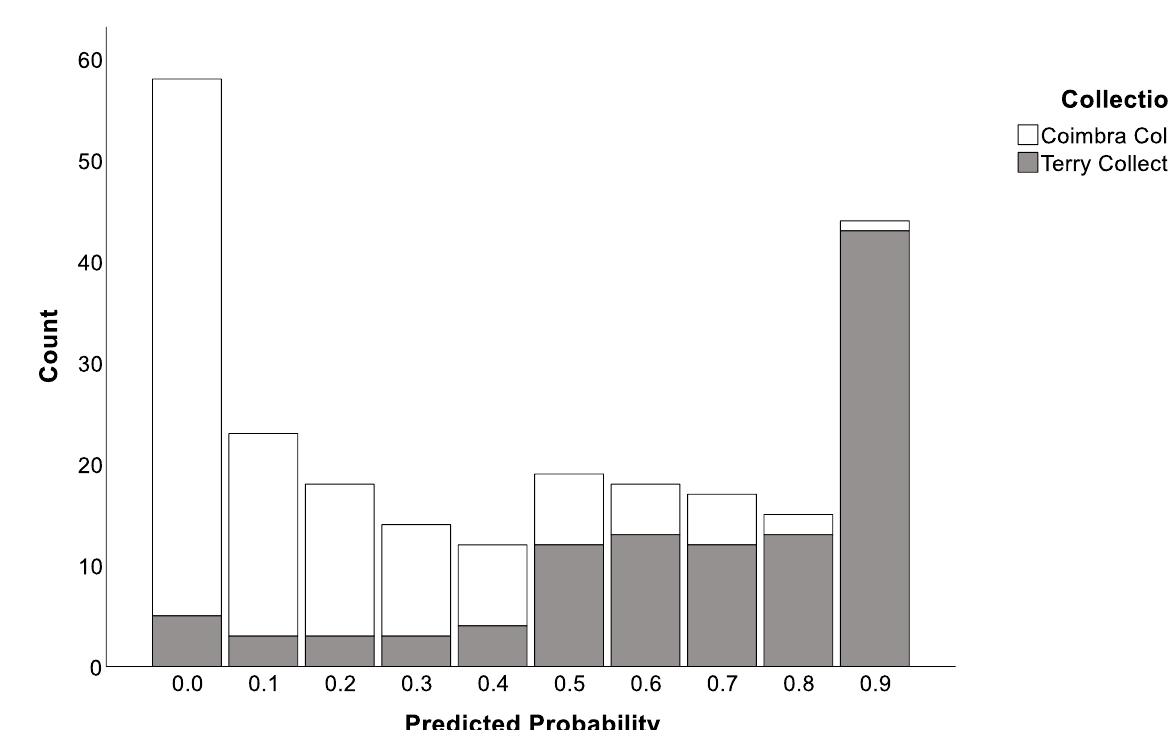
Figure 2. Distribution of p -values for the all-sexes Terry collection sample (n = 111) and the entire all-sexes Coimbra collection sample (n = 127).